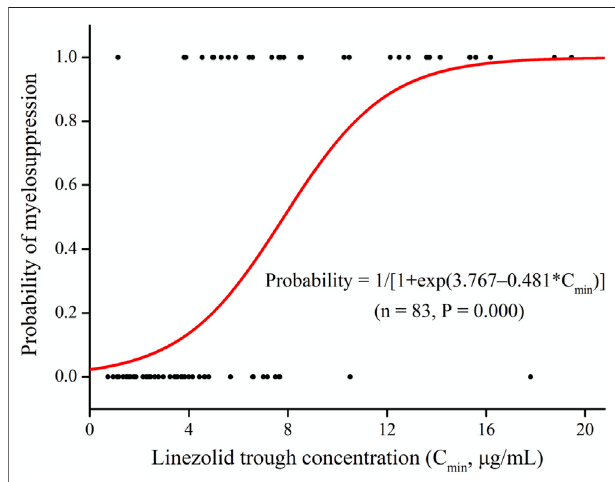
Frontiers in Pharmacology |